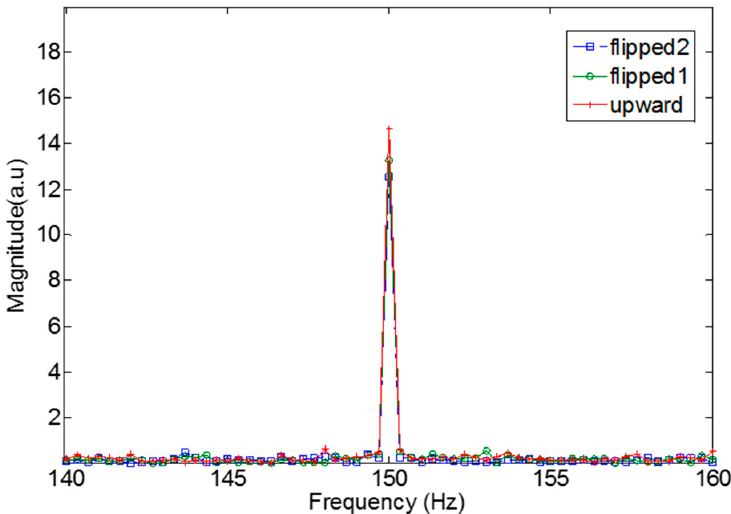
Figure 12. FFT data of 150 Hz tone used to test sensing beam at one location, with FBG facing upwards. This was followed by repeated tests with FBG facing downwards. The forced vibration was detected although the sensor was flipped in the z-direction.